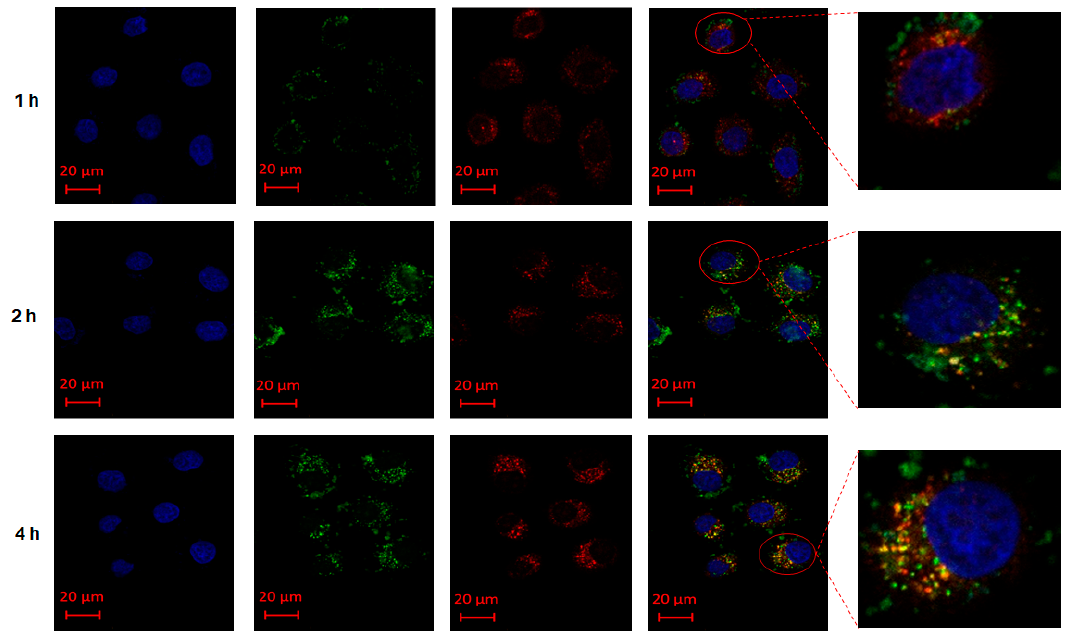
Figure 3. The internalization and endosome escape of M-MTX/siRNA in folate receptor (FR)-overexpressing HeLa cells: The internalization and endosome (red) escape of M-MTX loaded with FAM-siRNA (green) in the Hela cells was visualized by the confocal laser scanning microscopy (CLSM) at the first, second, and fourth hours. The red bar in the images was 20 μ m.